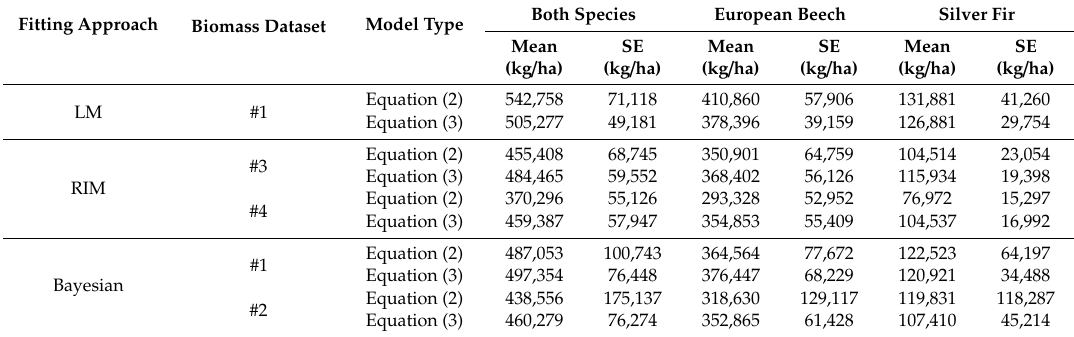
Table 6. Mean biomass per hectare and its standard error by model type and predictor combinations, presented for both species and for each individual